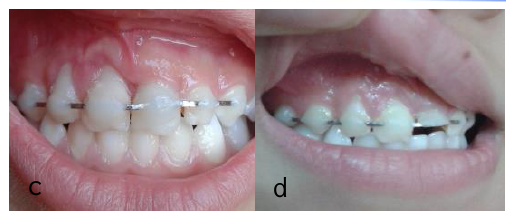
Figure 5: clinical results of follow-up; a- removal of sutures one week after suturing b, c and d show soft tissue healing (b-2 weeks, c-3 weeks and d-3 months). Note the color of the teeth has not changed.